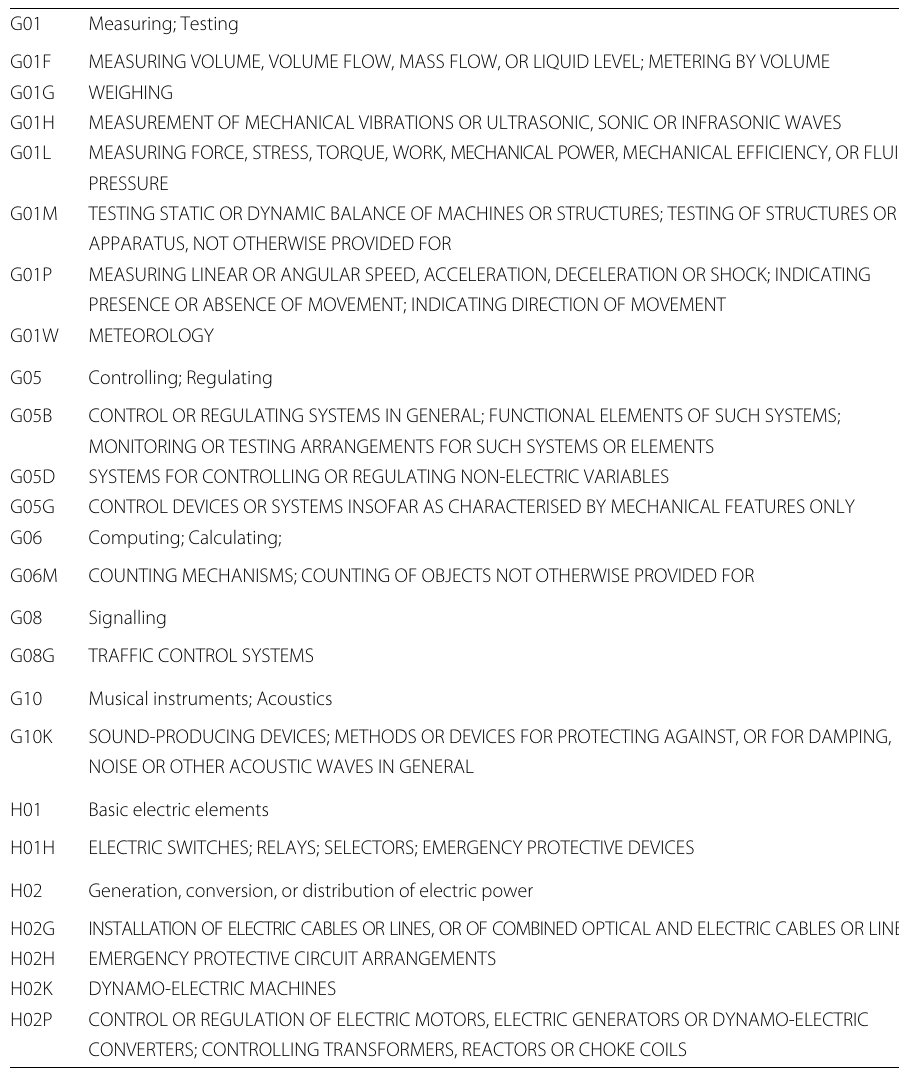
Table 2 IPC schemes of the central nodes in Section G and H in community containing